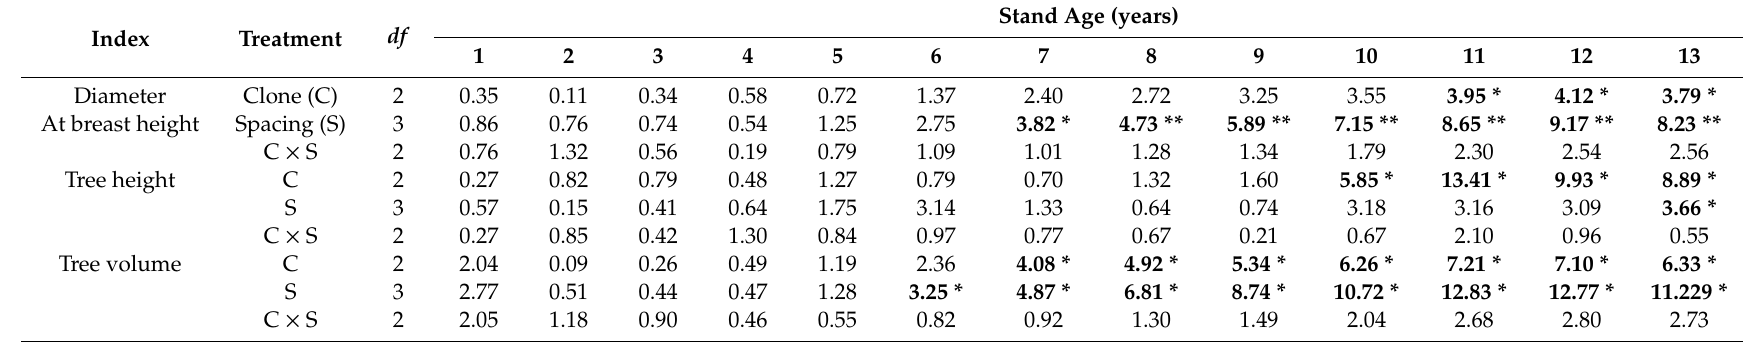
Table 2. F -values of two-way ANOVA for e ff ects of di ff erent clone and planting spacing on poplar growth indicators at the stand age of 13